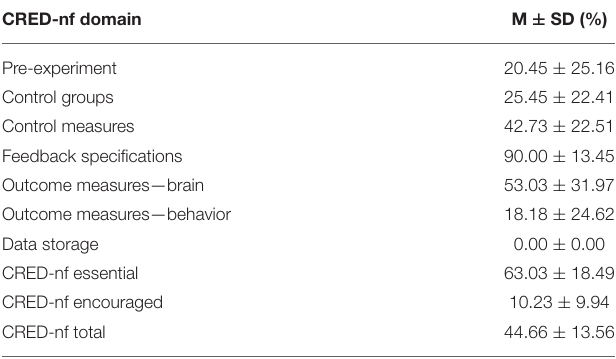
TABLE 4 | Reporting and design quality according to the CRED-nf